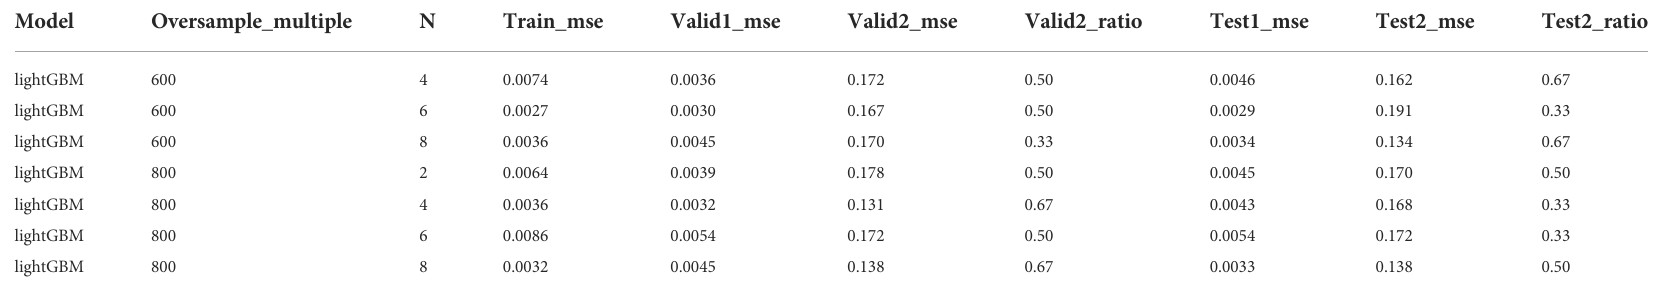
TABLE 2 The performance of lightGBM with representative undersampling interval N and repeated sampling multiples (complete data were provided in supporting information). Model